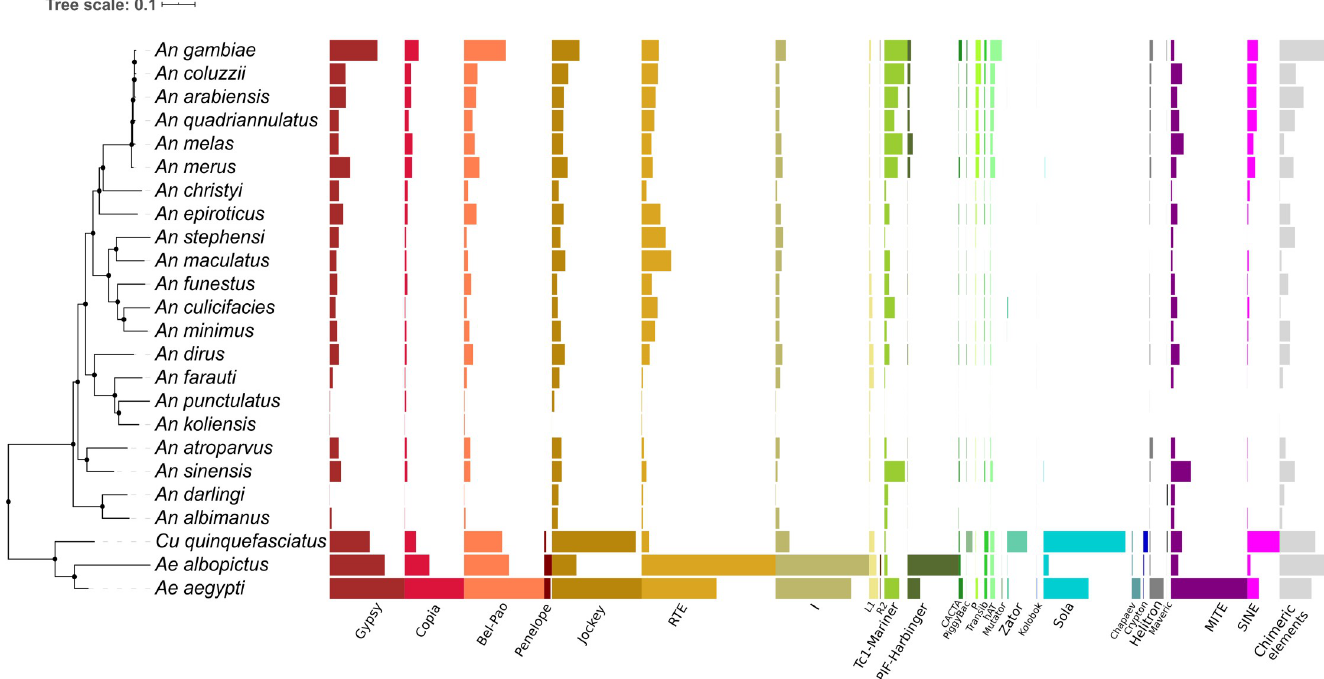
Fig 2. Proportion of each TE superfamily in the genomes of mosquitoes. A phylogenetic tree of 24 mosquito species showing the distribution of different TE superfamilies in mosquitoes. Each colored bar represents the proportion of each TE superfamily (names in X-axis) following Wicker et al. (2007) hierarchical scheme. Uncharacterized or order-only-characterized TEs are not shown (see S2